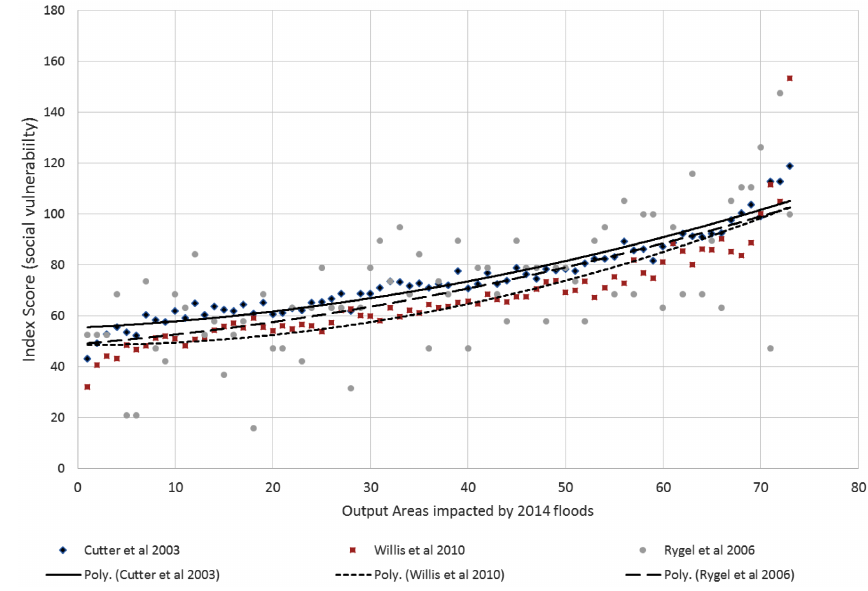
Figure 7. Output area comparison of social vulnerability index scores for the areas impacted by the 2013/2014 flooding.